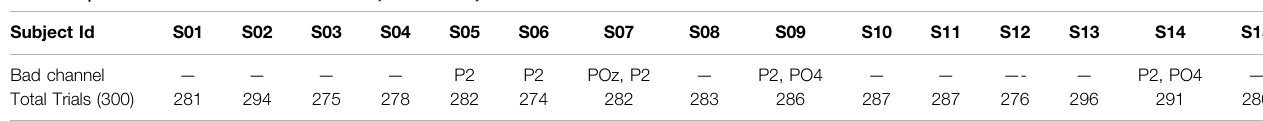
TABLE 3 | Number of trials selected from all subjects for analysis of EEG data with bad